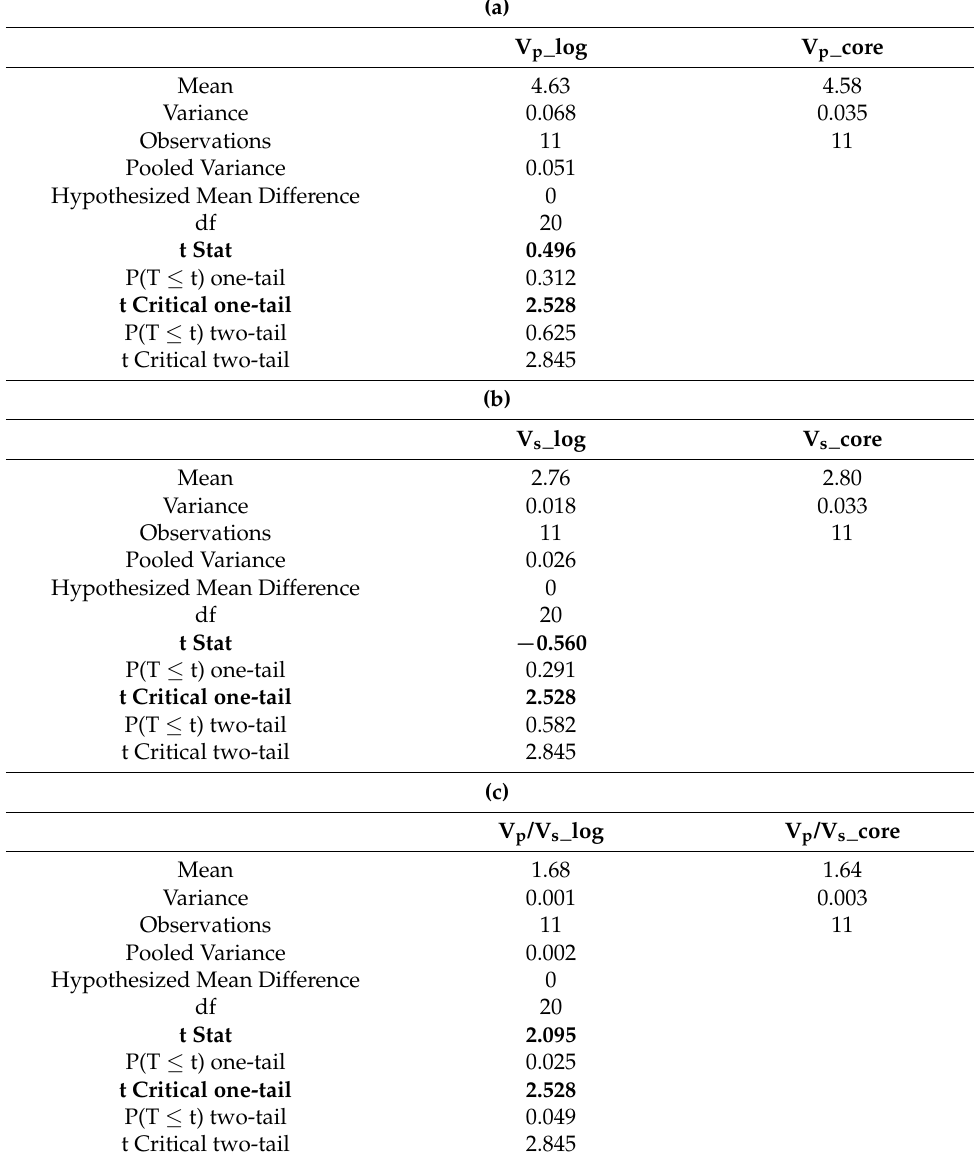
Table 4. (a) Student t -test result for the co-located sonic log and ultrasonic core P-wave velocity measurements (after fluid substitution to in situ saturations) in the second Bonespring formation. Result indicate there is no significant difference between the mean of the sonic log and ultrasonic core measurements. (b) Student t -test result for the co-located sonic log and ultrasonic core S-wave velocity measurements (after fluid substitution to in situ saturations) in the second Bonespring formation. Result indicate there is no significant difference between the mean of the sonic log and ultrasonic core measurements. (c) Student t -test result for the co-located sonic log and ultrasonic core V p /V s ratio measurements (after fluid substitution to in situ saturations) in the second Bonespring formation. Result indicate there is no significant difference between the mean of the sonic log and ultrasonic core